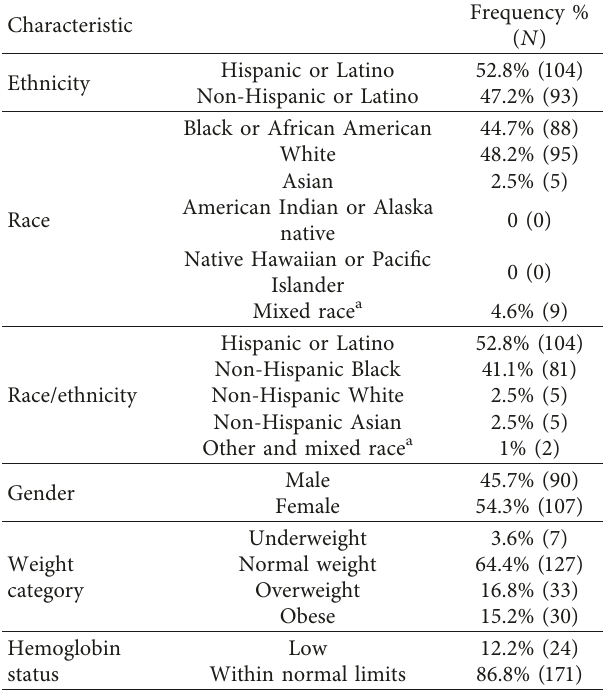
Table 1: Description of study sample ( N � 197). Table 2: Daily average beverage intake in ounces, by